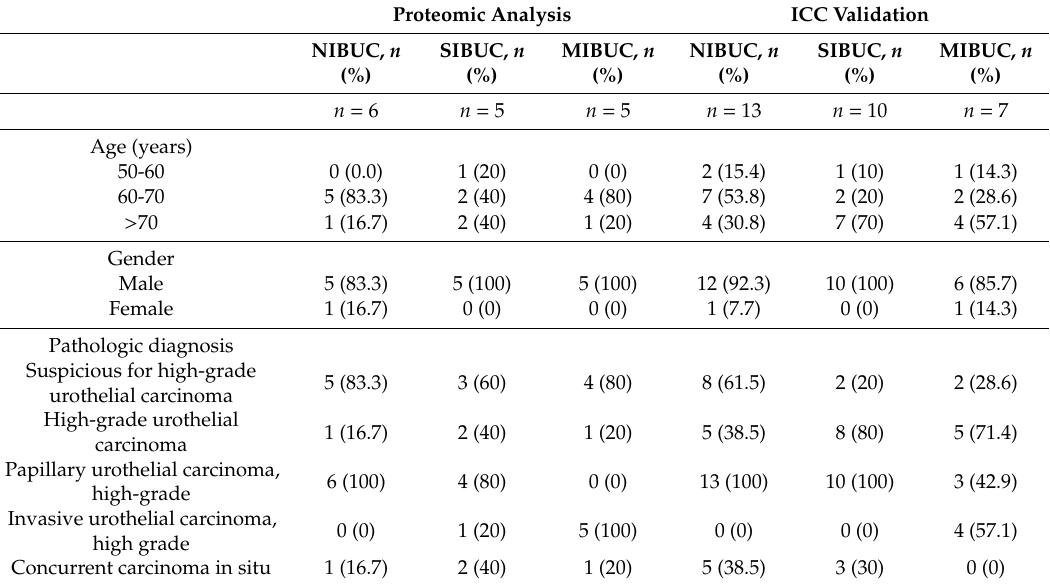
Table 2. Clinicopathologic features of bladder urothelial carcinoma (BUC) in liquid-based cytology (LBC)